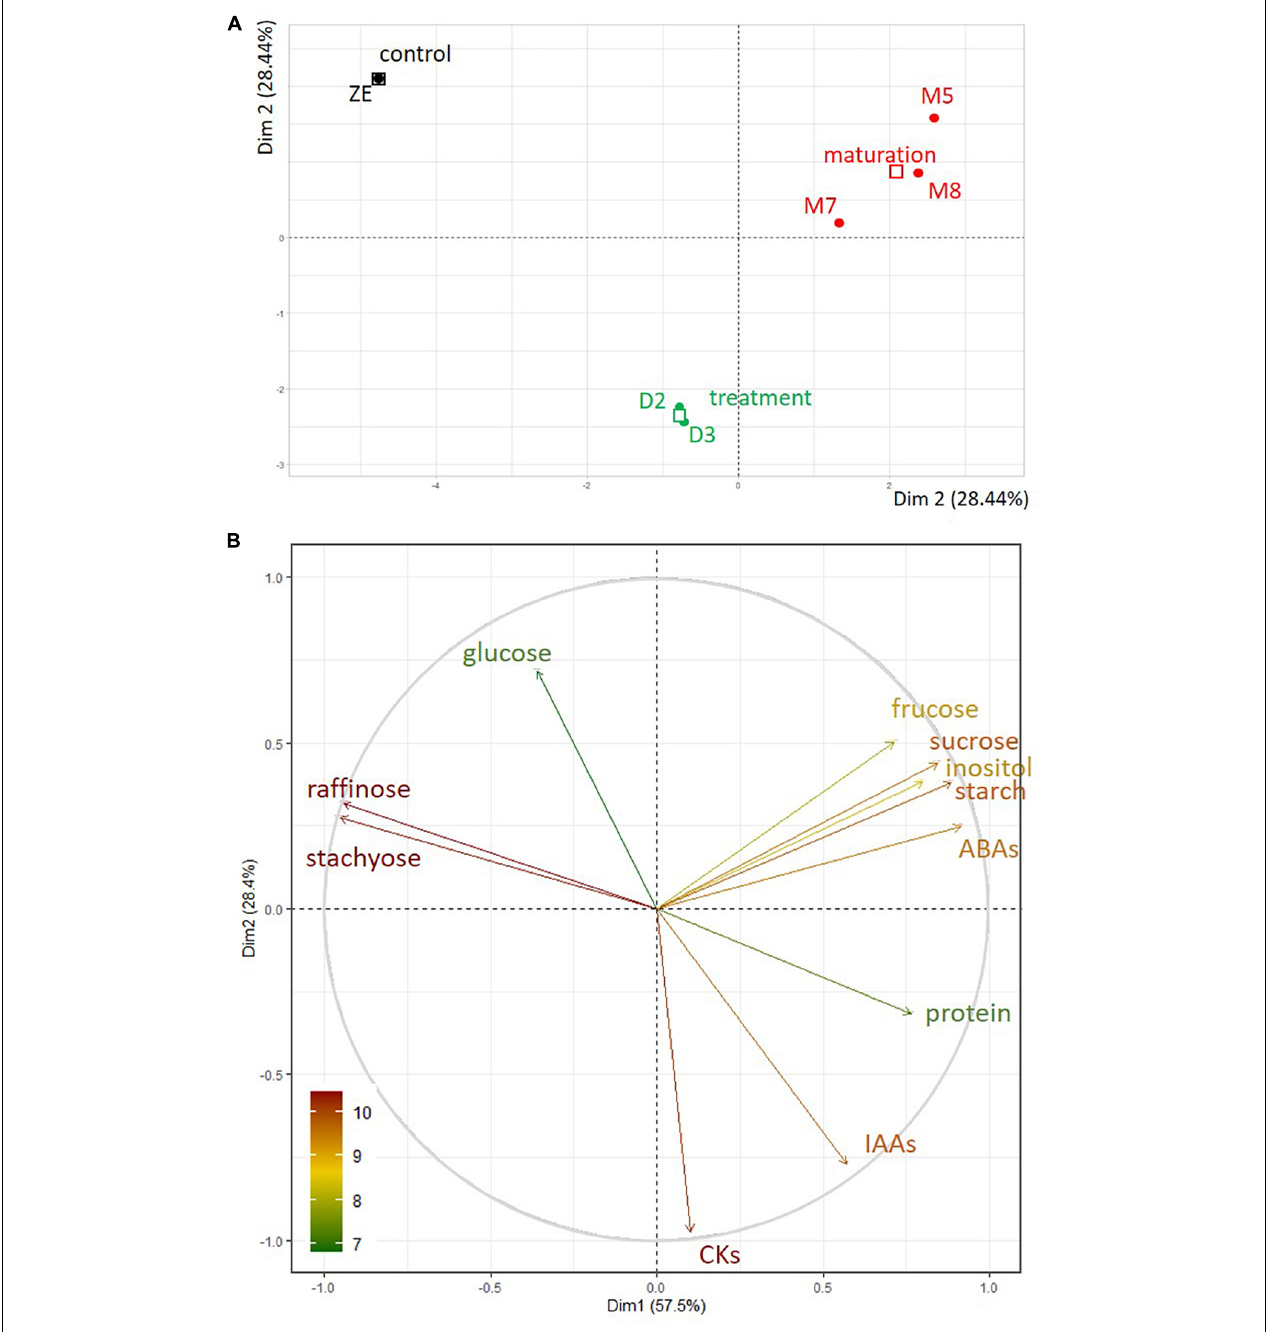
FIGURE 10 | (A) PCA of somatic embryos maturing during five (M5) or eight (M8) weeks or desiccated during two (D2) or three (D3) weeks, and dry zygotic embryos (ZE) according to their biochemical dataset (stachyose, raffinose, sucrose, glucose, fructose, inositol, starch, protein, ABAs, IAAs, CKs), in the factorial plan Dim 1 - Dim 2. (B) Correlation circle between the biochemical variables in the PCA of the samples in the factorial plan Dim 1 - Dim 2. The contribution of the biochemical variables is represented by the color of their respective vector.